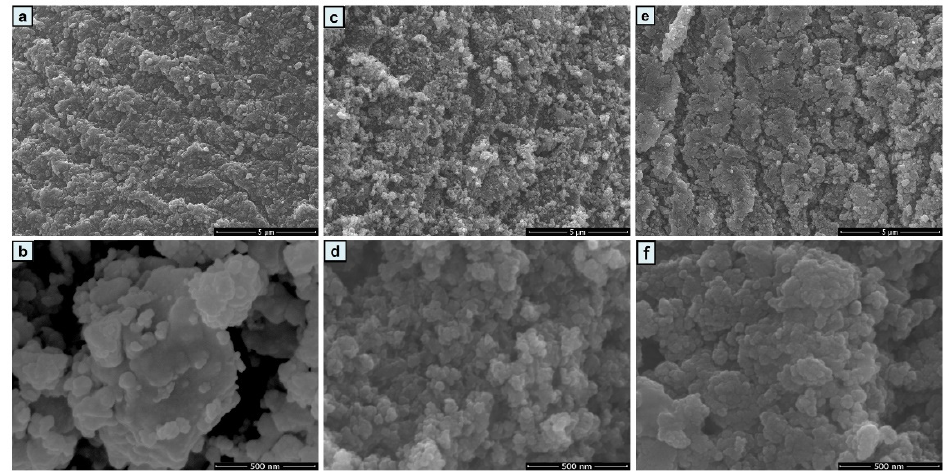
Figure 4. Low and high magnification SEM images of ( a , b ) CuS / C-80, ( c , d ) CuS / C-120, and ( e , f ) CuS / C-160.